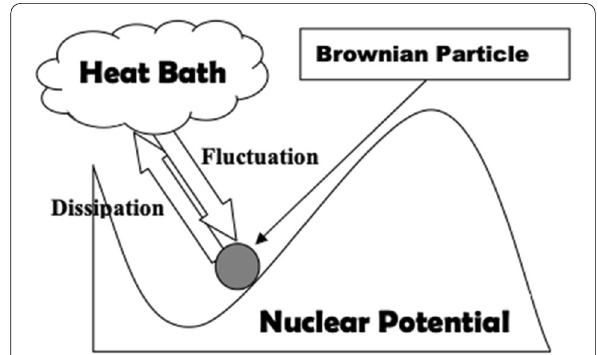
Fig. 3 A schematic diagram of the dissipative dynamical model for fission. The figure is adapted from